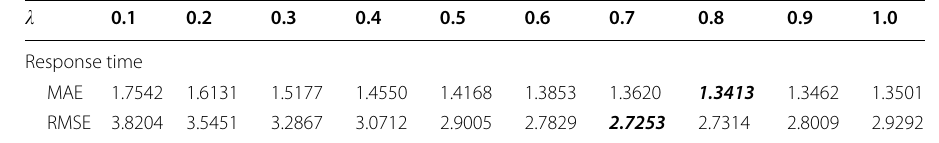
The significance of “bold and italic values" highlights the best value in MAE and RMSE respectively, which is used to choose the best (cid:31)